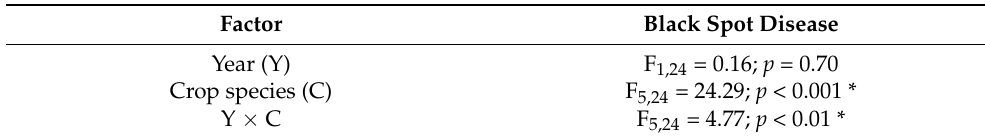
Figure 2. Mean area under the disease progress curve (AUDPC) values of Alternaria black spot ( A. brassicae ) infection in different cruciferous oilseed crops in the two study years. Error bars denote the standard error of the means. Means followed by different capital letters above each bar indicate a significant influence ( p < 0.05) of cruciferous oilseed crop species in different years (Tukey HSD test). Means followed by different lowercase letters above each bar indicate a significant influence ( p < 0.05) of year (Tukey HSD test). Table 4. Impact of study year and species and their interaction on Alternaria black spot ( A. brassicae ) AUDPC values according to a two-way